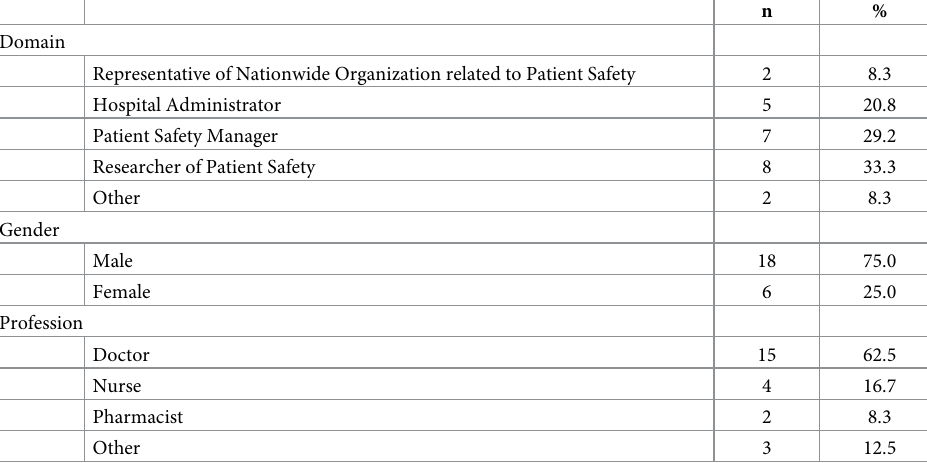
Table 2. Baseline characteristics of